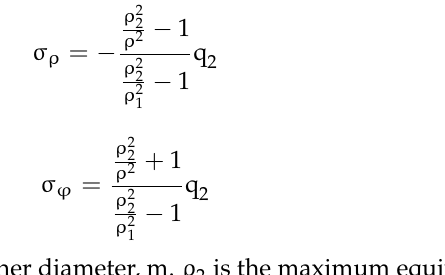
Figure 11. Radial shear force distribution of the thin